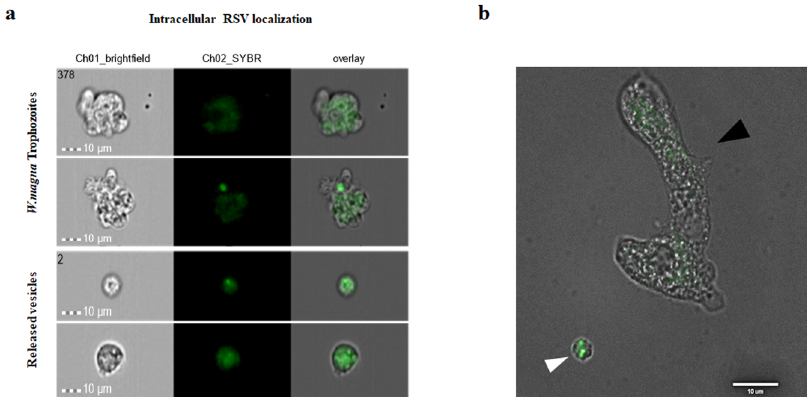
Fig. 1 Intracellular RSV localisation. a Internalised GFP-RSV virus particles in live amoebae (trophozoites and released vesicles) using ImageStream ® fl ow cytometry. b GFP-RSV virus particles packaged in excreted vesicles by W. magna using fl uorescent microscopy (100x), released vesicle (white arrowhead) amoeba trophozoites (black arrowhead).